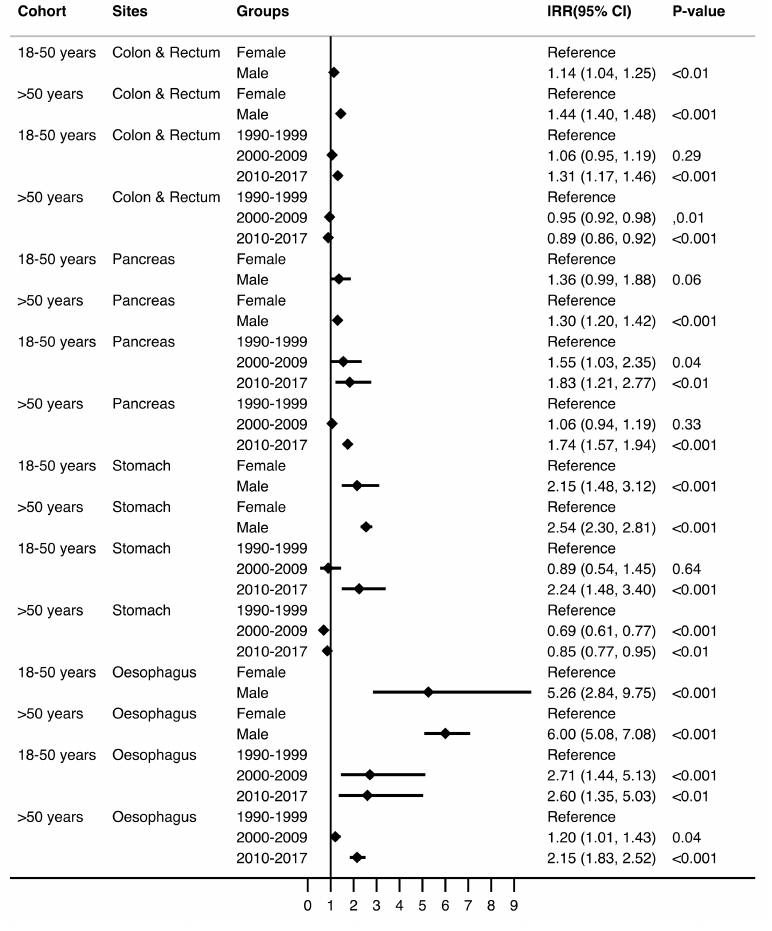
Figure 2. Incidence rate ratios (IRR) and 95% CI (Poisson regression model) for sex and era by primary sites between two age groups ( n =